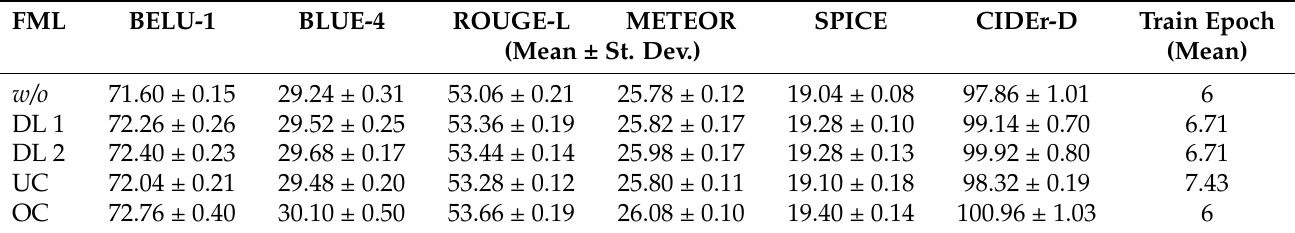
Table 7. Performance comparison according to FML. w/o applies CI without FML. DL 1 is Dense Layer 1, DL 2 is Dense Layer 2, UC is Undercomplete, and OC is Overcomplete. Training seven times for each model.